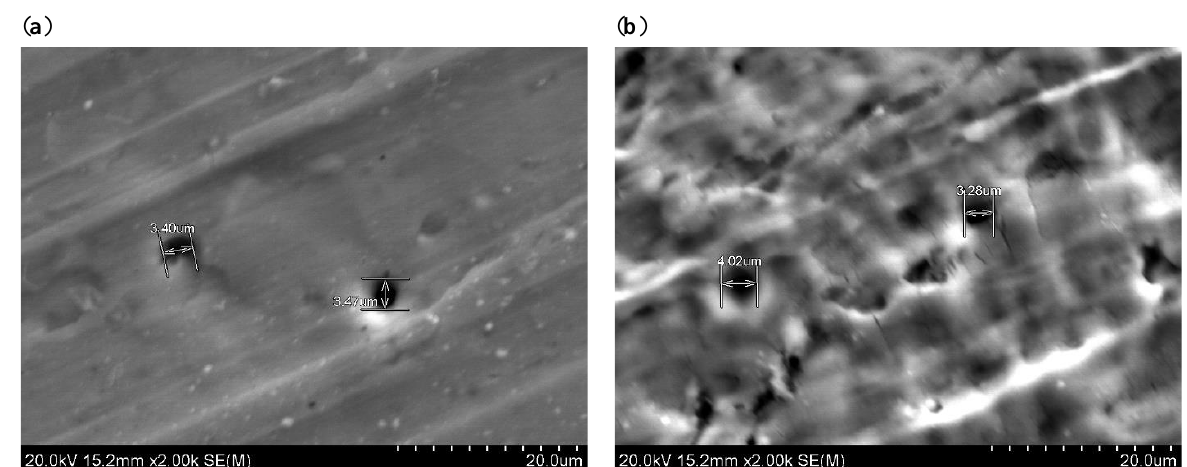
Figure 6. SEM images showing diameter of crater formation in ( a ) SG1.5 DD, ( b ) SG1.5 TD. Regardless of all the damage caused to the coatings by cavitation test, it was observed that some small parts of the coatings remained on SG1.5 DD and SG1.5 TD samples even after 36 min of the test. Figure 7 shows SEM micrographs of thickness of SG1.5 DD and SG1.5 TD after 36 min of cavitation test.